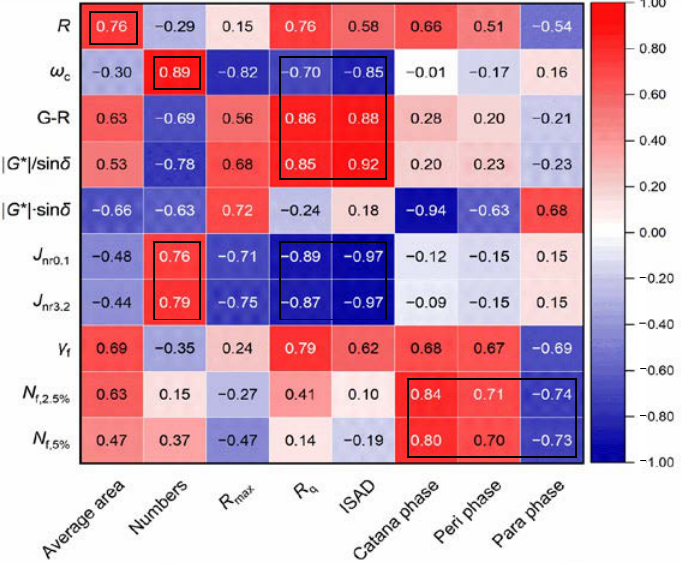
Figure 10. Correlations between morphology parameters and performance parameters. Note: For the Pearson correlation coefficient, the closer it is to 1 or − 1, the stronger the linear correlation. A positive value means a positive correlation and a negative value means a negative